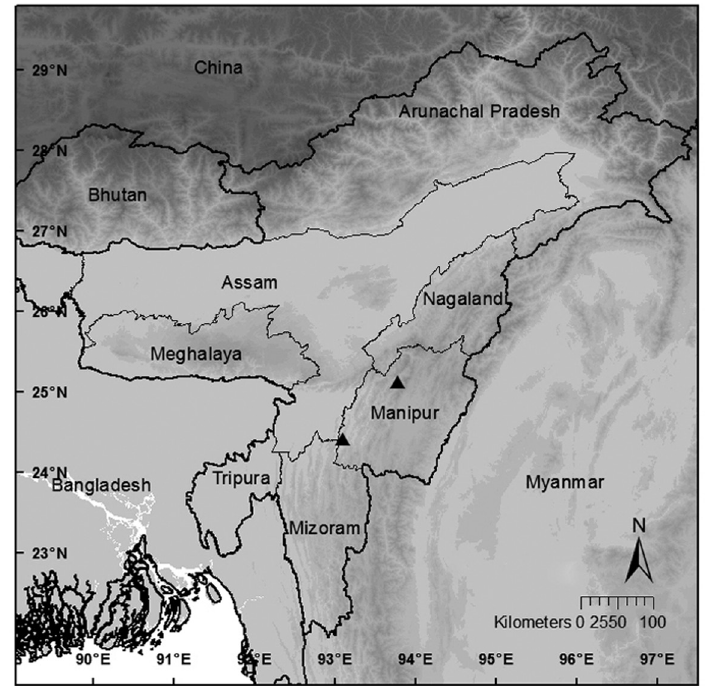
Fig. 41. Map showing the location of B. obversa C.B.Clarke